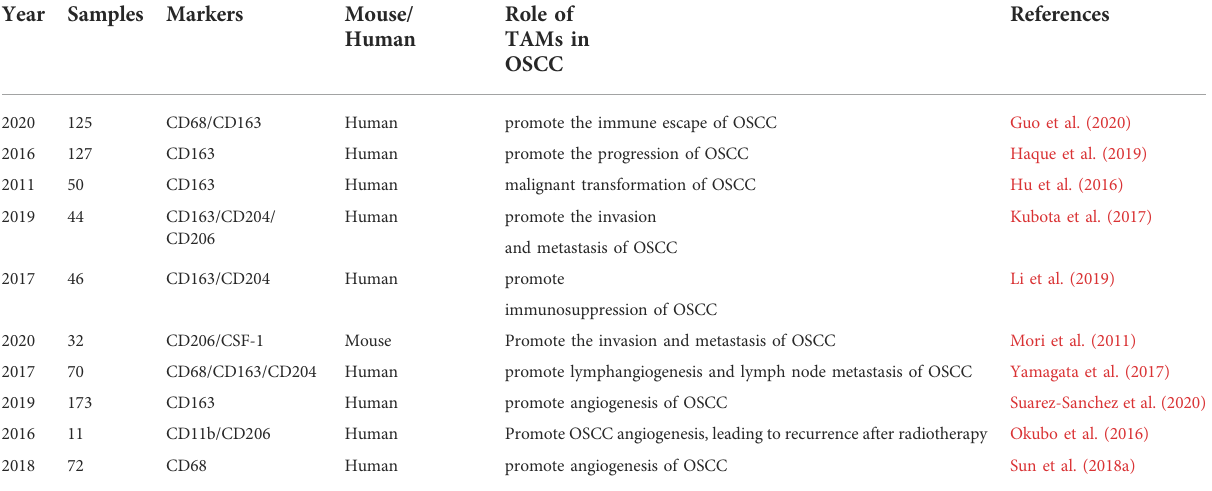
TABLE 1 Role of TAMs in